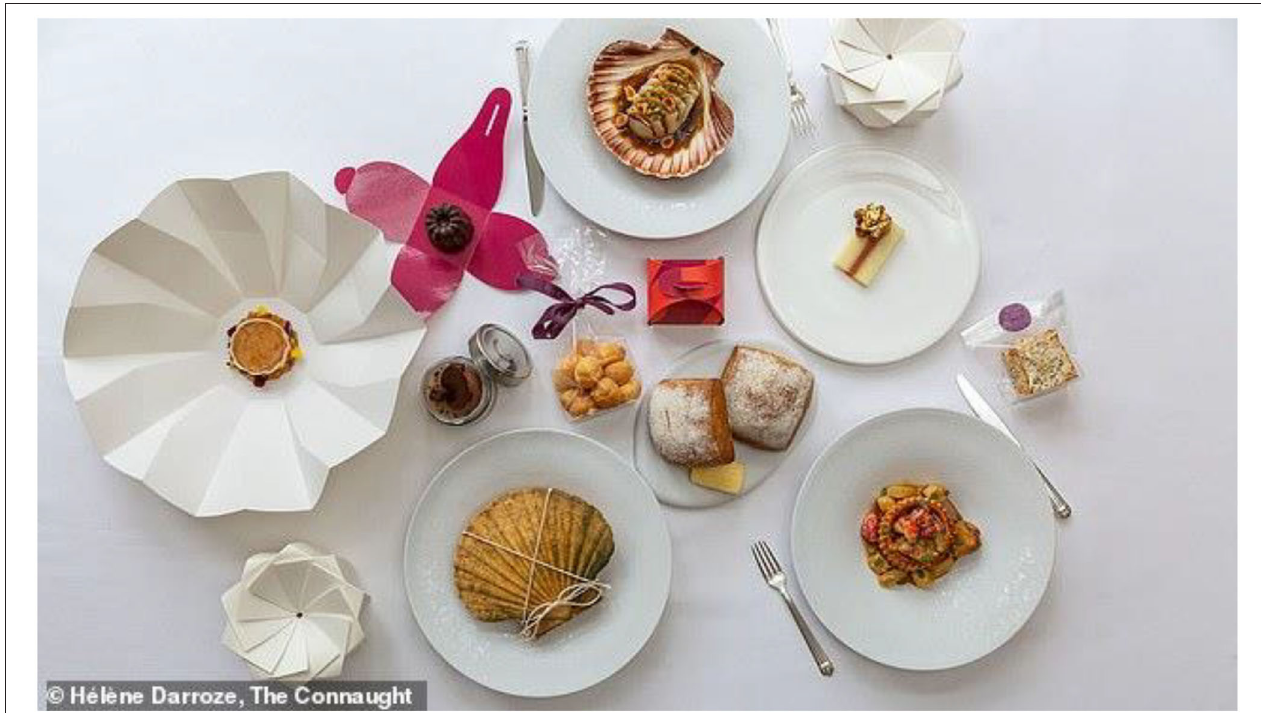
FIGURE 3 | £415 takeaway meal for two from Hélène Darroze at The Connaught Hotel, London (McCarthy, 2020). Figure copyright Hélène Darroze, The